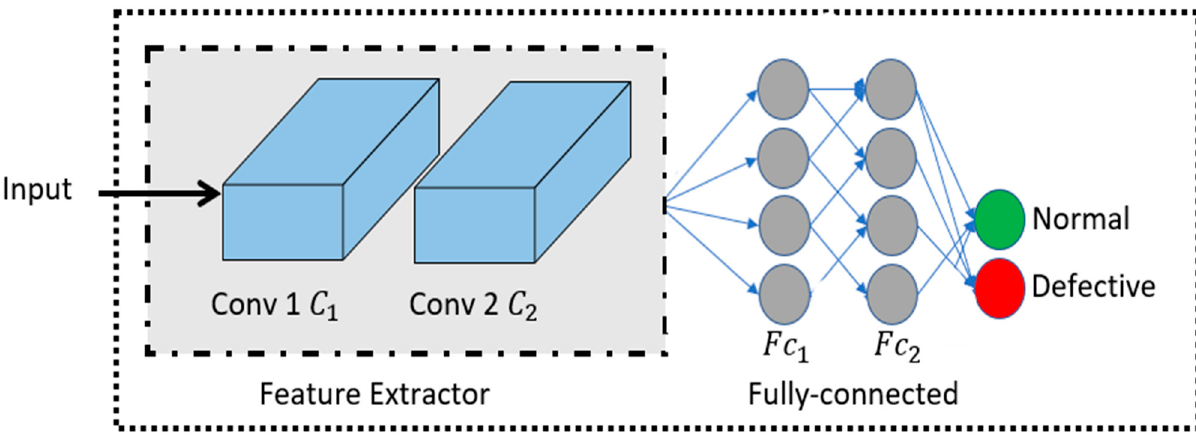
Figure 6. Proposed PV-CrackNet abstract view.